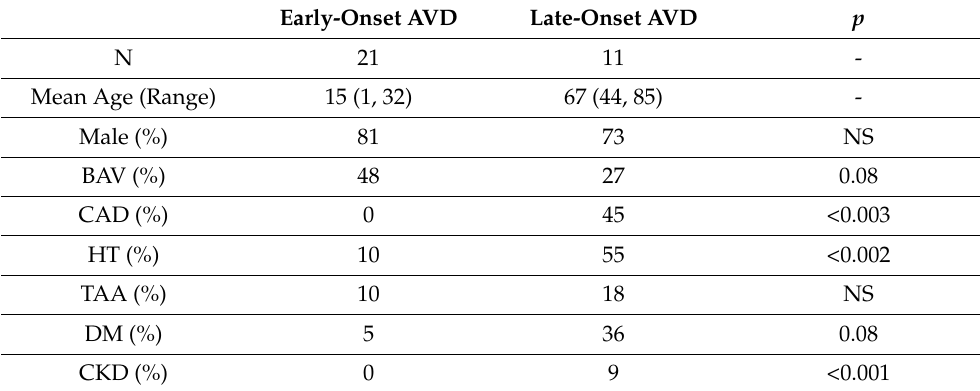
Table 1. Non-syndromic AVD study population demographics and comorbidities.